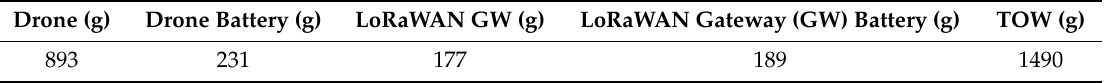
Table 1. TOW of our LoRaWAN-drone gateway solution.